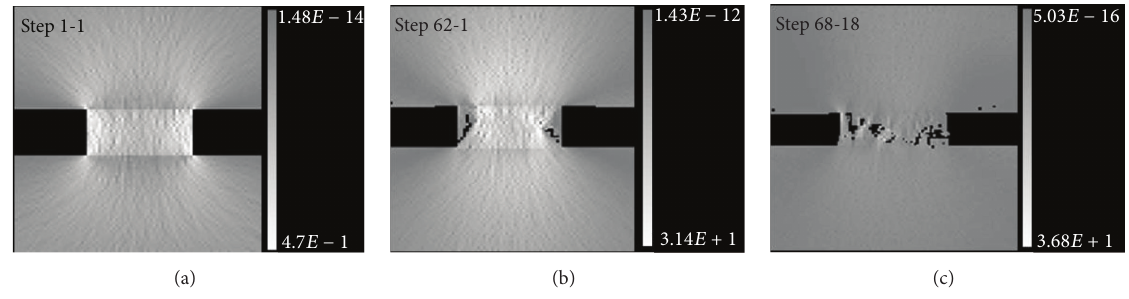
Figure 18: Plot of shear stresses around a pillar with width-to-height ratio =